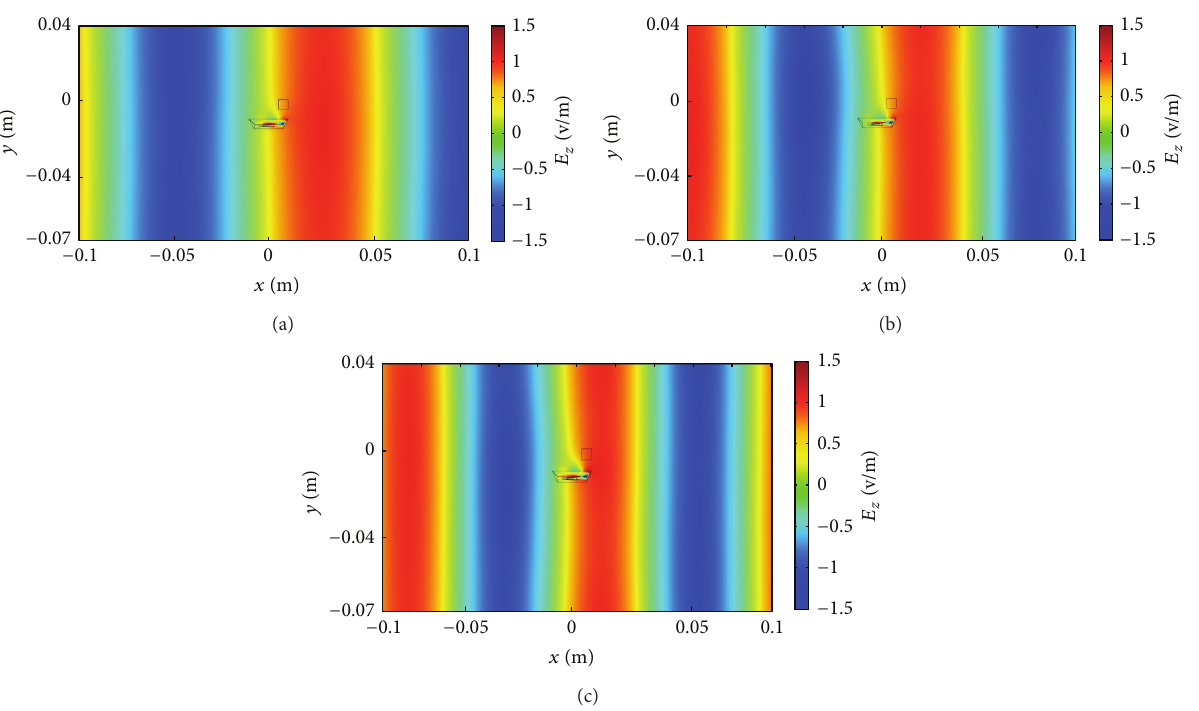
Figure 7: Electric field distribution of the trapezoid complementary illusion cloak for the incident plane wave with different frequencies: (a) 2 GHz; (b) 2.5 GHz; (c) 3 GHz.